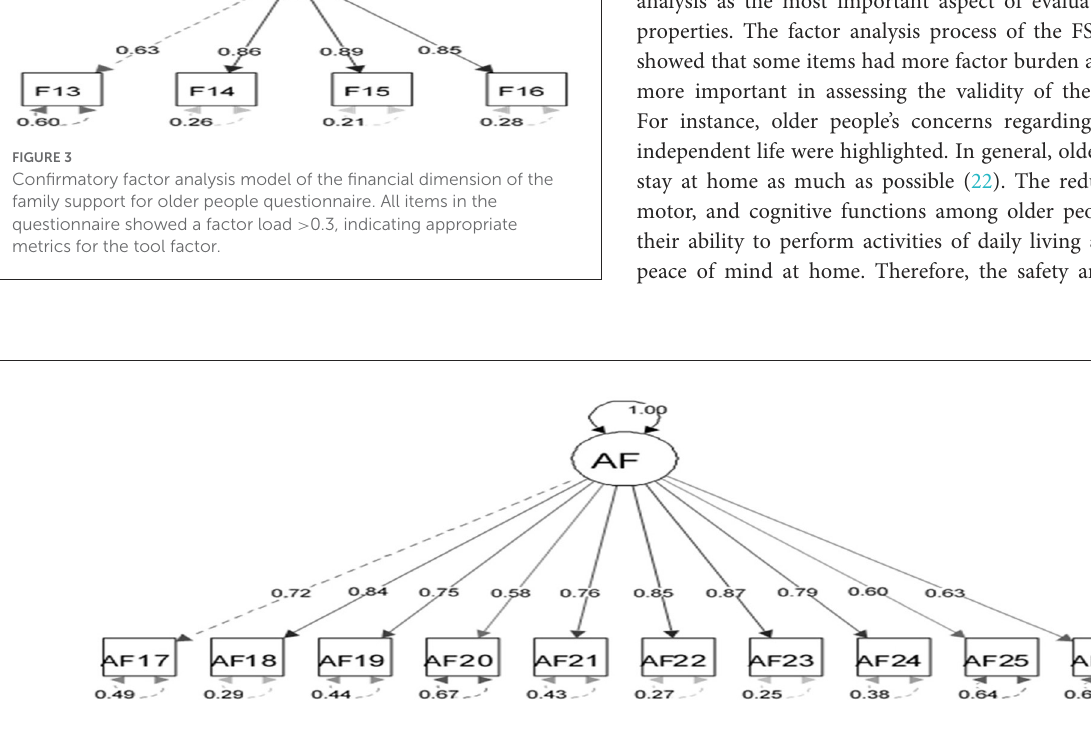
FIGURE4 Confirmatory factor analysis model of the affective dimension of the family support for older people questionnaire. All items in the questionnaire showed a factor load > 0.3, indicating appropriate metrics for the tool factor.